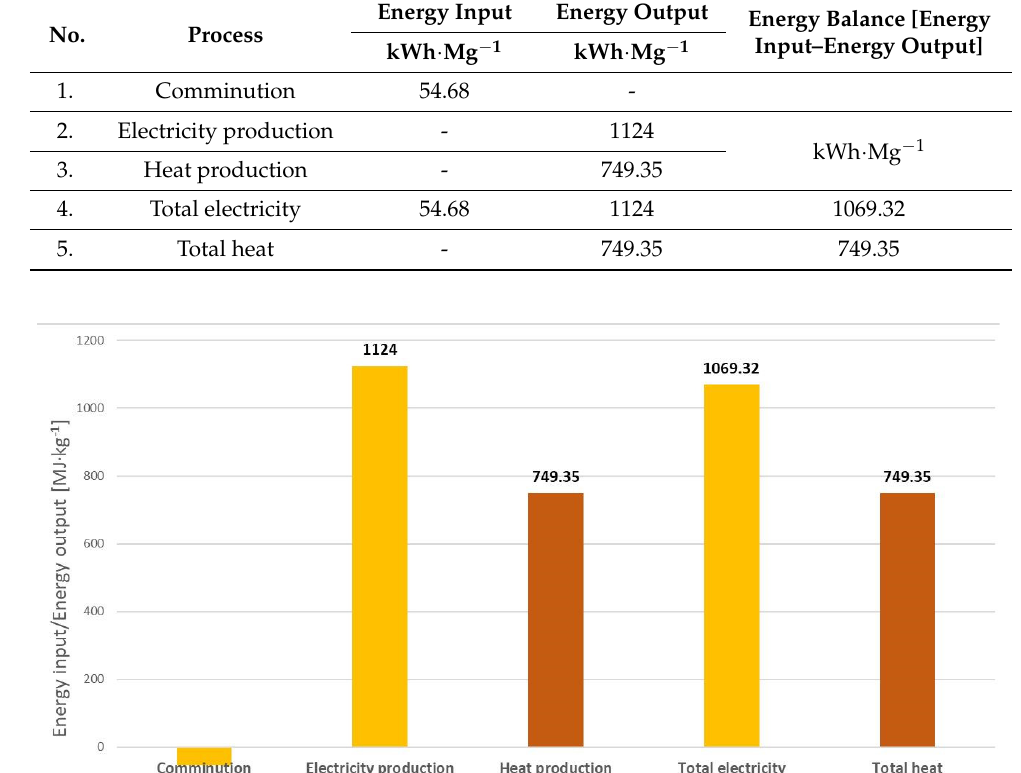
Table 9. The energy balance of biogas generated from comminuted Silphium perfoliatum L.